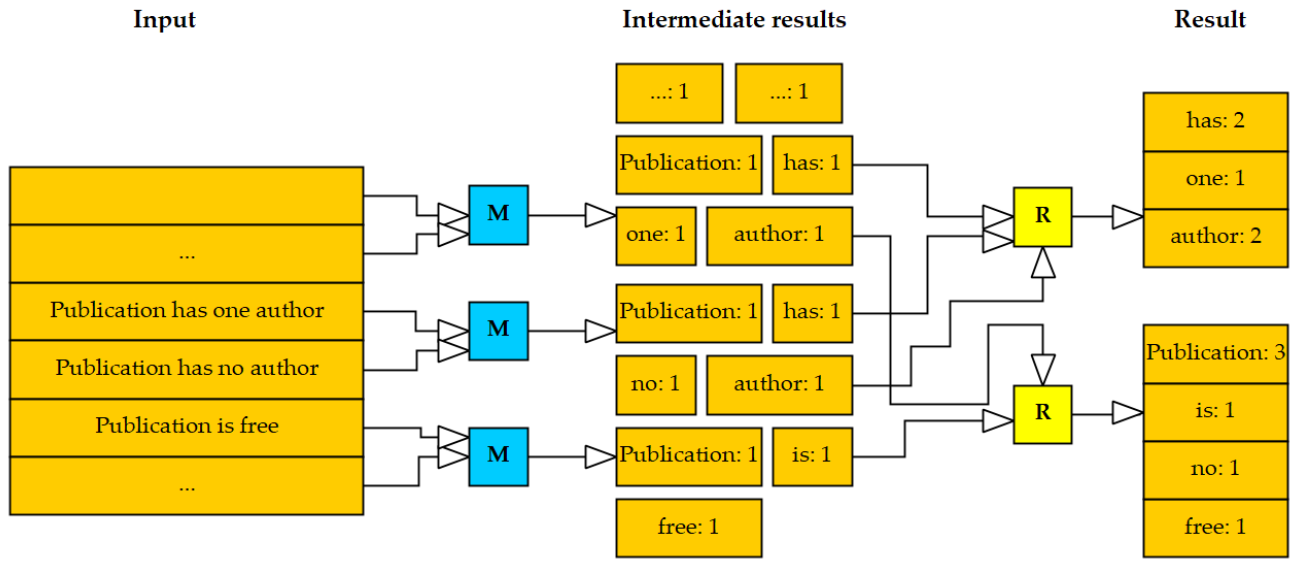
Figure 5. Schematic process of MapReduce.